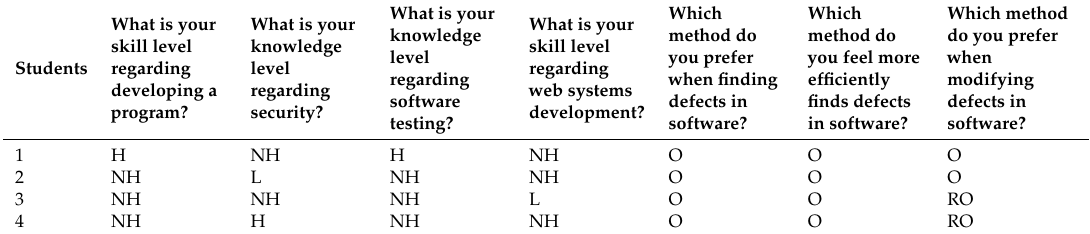
Table 2. Results of the Before and After Questionnaire (Step 1, 5) (VH: very high, H: high, NH: not high, L: low, O: our method, RO: relatively our method, RE: relatively existing method, E: existing method).